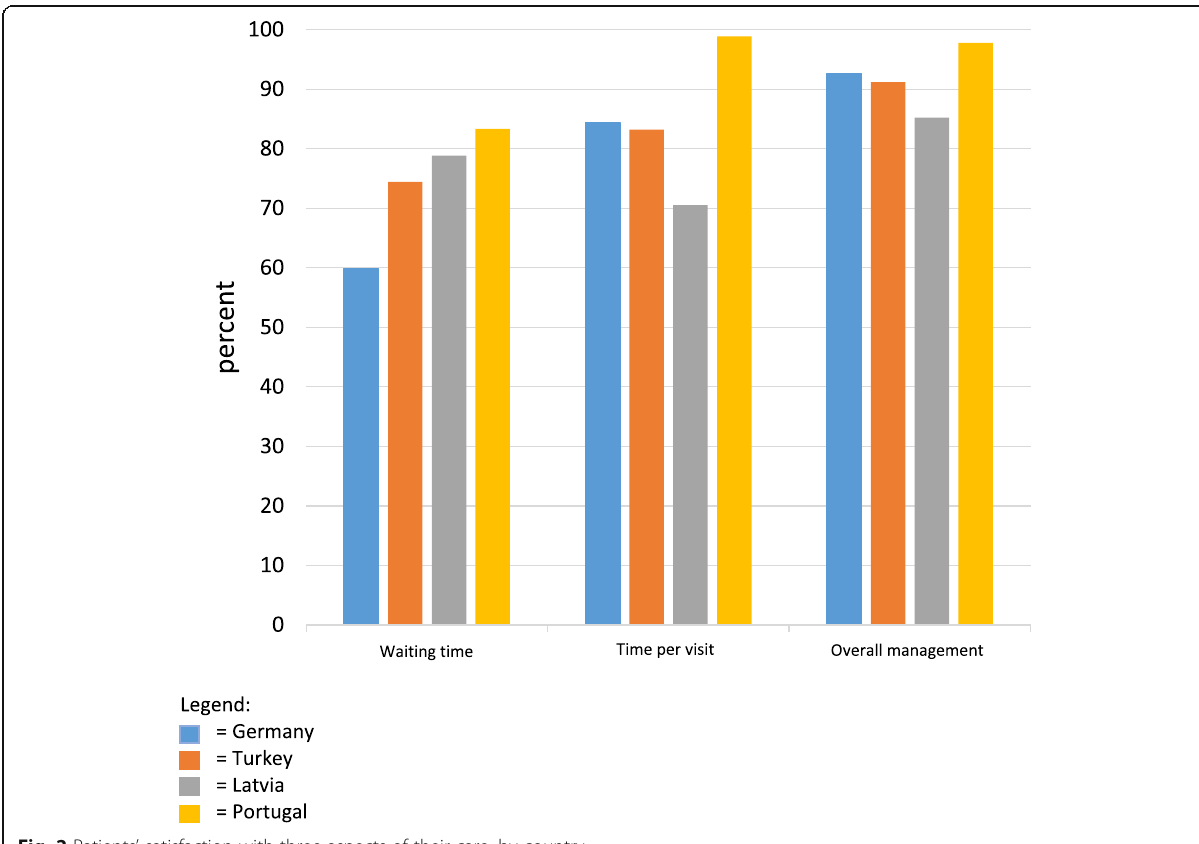
Fig. 2 Patients ’ satisfaction with three aspects of their care, by